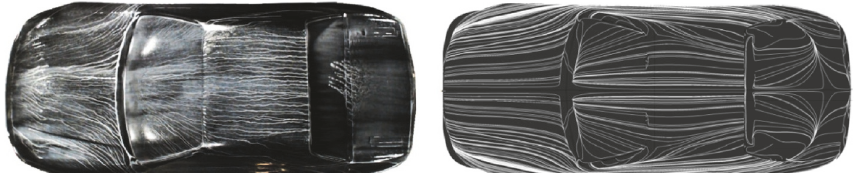
Figure 7: Comparison of the experimental visualization of the oil flow over a clean configuration of the car body (left) and from the CFD calculations (right).